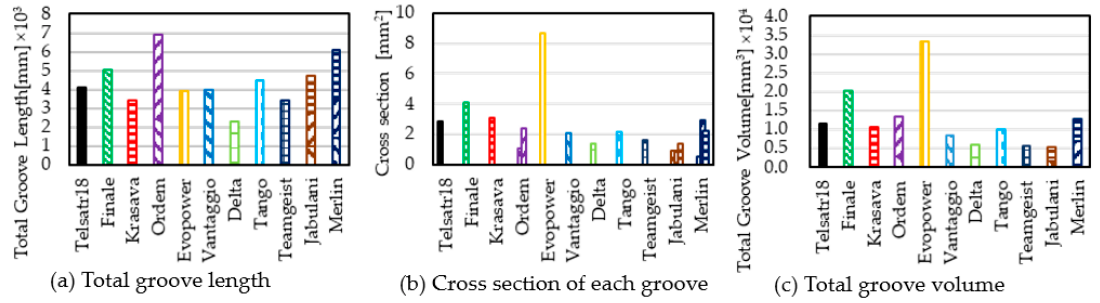
Figure 2. Specifications of ball